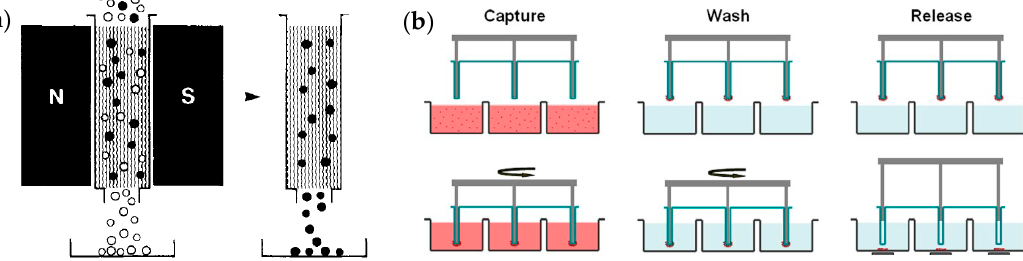
Figure 12. Two typical systems of magnetic beads assisted trapping and releasing of cells. ( a ) Column-based system. Left: Under the effect of external magnetic field, cells labeled with superparamagnetic nanobeads (black dots) are trapped on the matrix of column, while unlabeled cells (white dots) can go through the column. Right: The trapped cells can be released as soon as the magnetic field is removed. “N” and “S” denotes the north pole and south pole of the magnet, respectively; ( b ) MagSweeper system. Blood samples in the capture wells are labeled with magnetic nanobeads. The magnetic rods covered with a thin layer of plastics sweep through the wells in concentric circular loops to magnetically attract target cells labelled with nanobeads. Loosely attracted unwanted cells are washed off from the magnetic rods with them moving in circular loops. Finally, the magnetic rods are immersed into a new buffer solution and disengage from the plastic covers. Cells labeled with magnetic nanobeads are released under the effect of magnetic fields setup by magnets located under the wells. Figure ( a ) is reprinted from [152], Figure ( b ) is reprinted from [154].